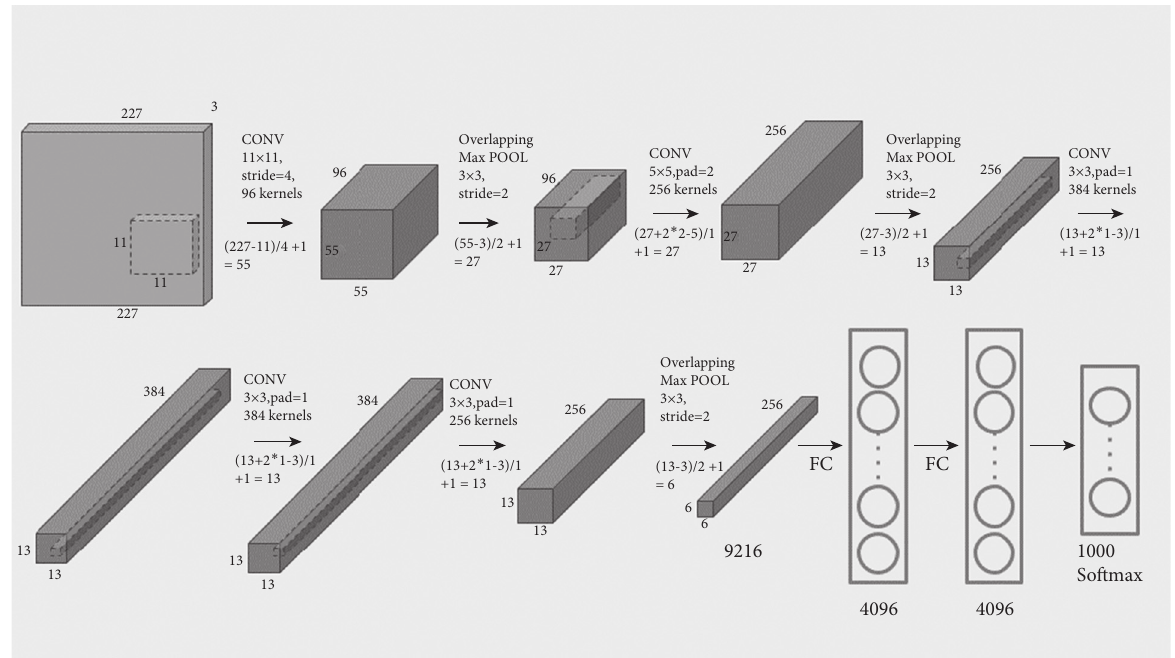
Figure 7: AlexNet model as transfer learning model used for feature